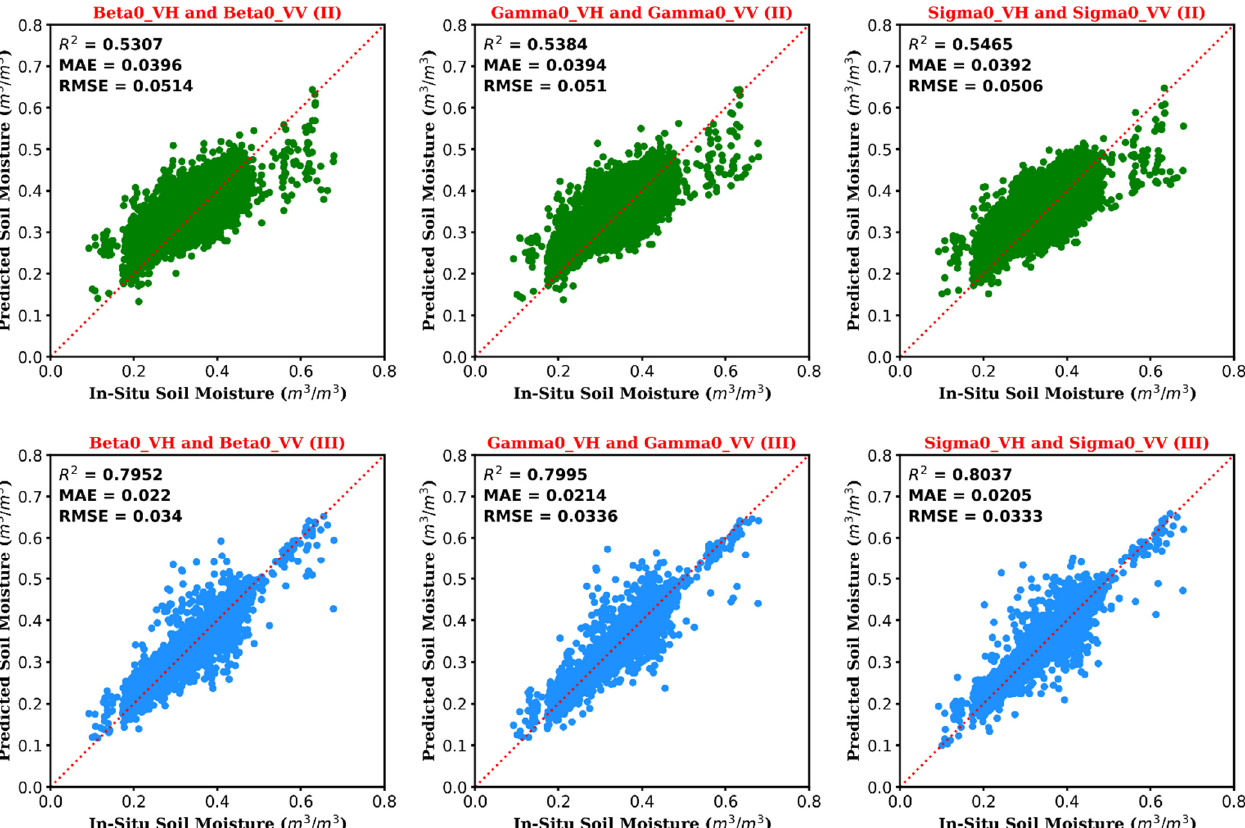
Figure 6. Validation accuracy for CNN architecture (C ( II ) ) vs. validation accuracy for CNN architecture (C ( III )